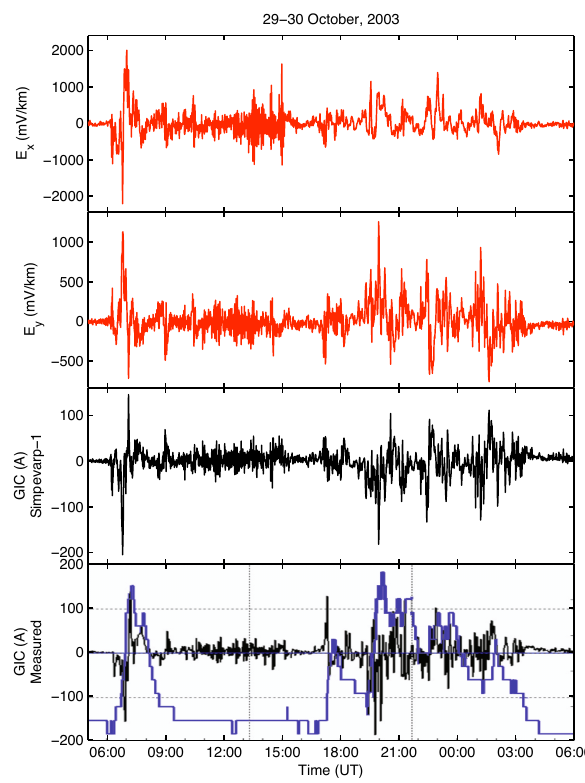
Fig. 8. The bottom panel shows measured GIC (black curve) and transformer temperature (blue curve) at Simpevarp-1 (#20 in Fig. 2) from 05:00UT on 29 October to 06:00UT on 30 October 2003. The total range from bottom to top in the figure for the temperature is roughly ten degrees. There are no measurements at later times on 30 October due to a problem with the monitoring system (private communication with H. Swahn). The second panel from the bottom presents calculated GIC at Simpevarp-1. The two upper panels refer to the calculated geoelectric field at the more southern red grid point in Fig.